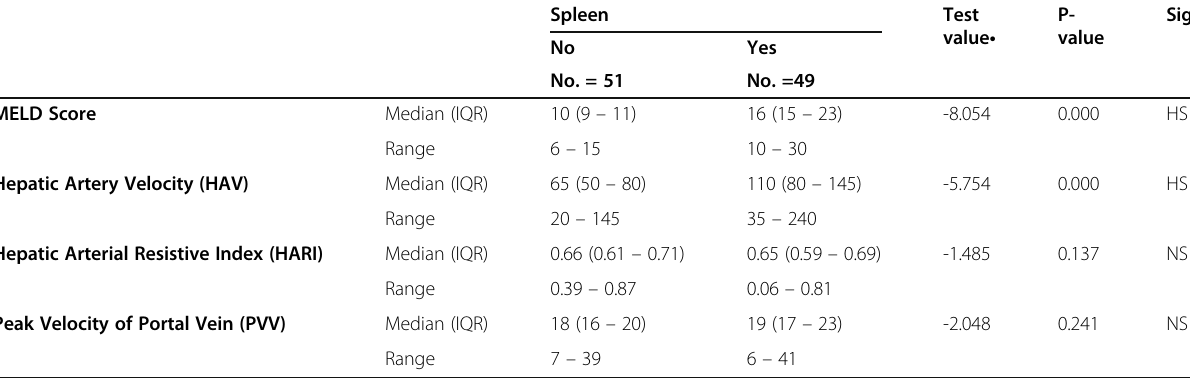
Table 3 The spleen size correlation with MELD and the hepatic Doppler parameters